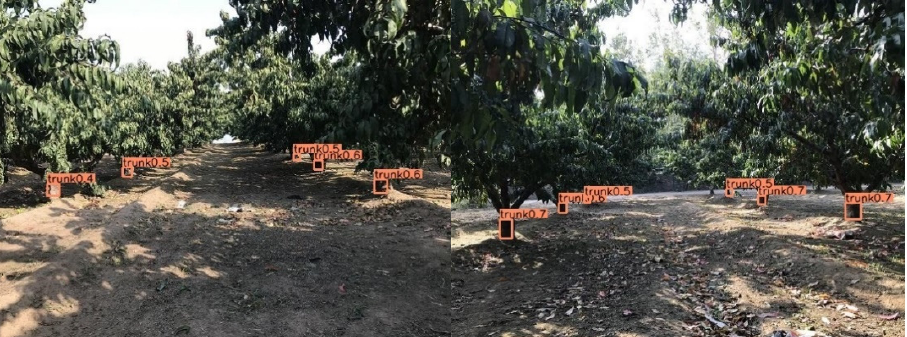
Figure 9. Detection results of trunk under normal sunlight.